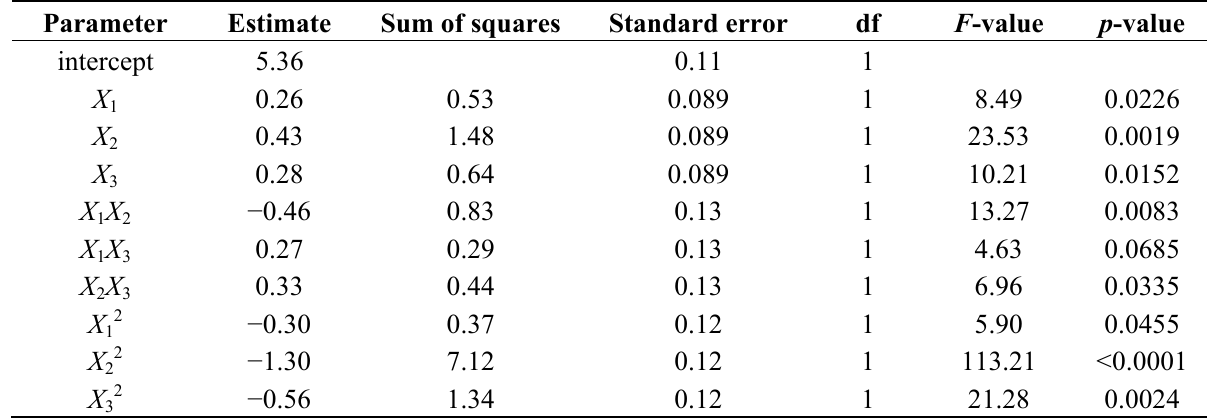
Table 2. Test result of significance for regression coefficients.